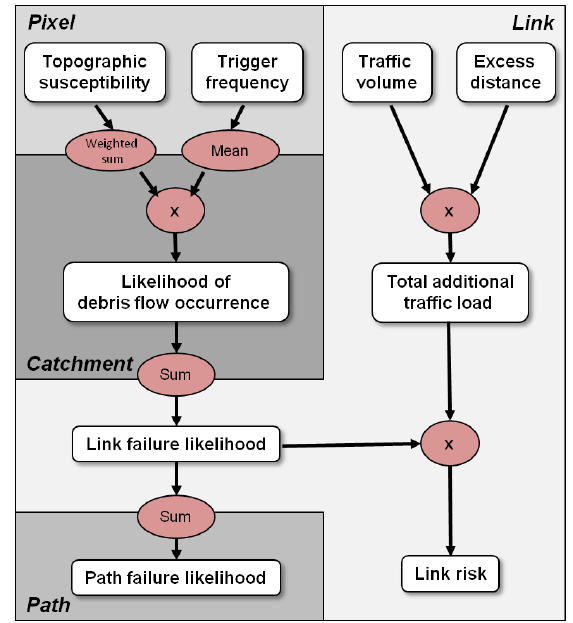
Figure 4. Flow chart showing aggregation and processing of data on different scales: pixel, catchment, link, and path. For detailed description of aggregation process see text.